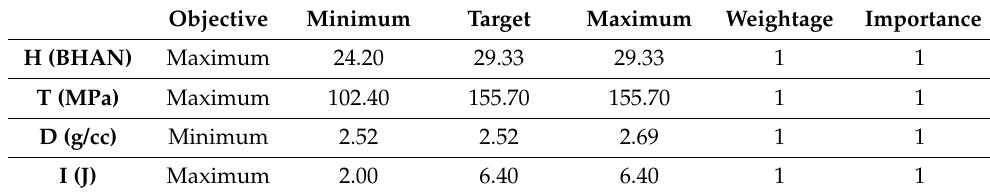
Table 4. Optimisation Parameter.